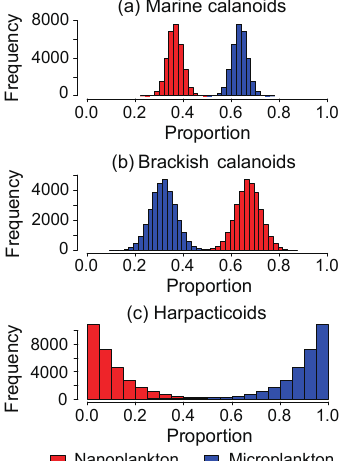
Figure 6. Comparison of the dietary compositions of major cope- pod groups: (a) Marine calanoids, including Acartia hudson- ica , Acartia omorii , Bestiolina coreana , Calanus sinicus , Clau- socalanus furcatus , Centropages abdominalis , Centropages dor- sispinatus , Paracalanus aculeatus , Paraeuchaeta plana , Labido- cera rotunda , Labidocera euchaeta , Tortanus dextrilobatus , and Tortanus forcipatus ; (b) brackish calanoids, including Acartia ohtsukai , Acartia erythraea , Eurytemora Pacifica , Paracalanus parvus , Pseudodiaptomus koreanus , Pseudodiaptomus marinus , and Sinocalanus tenellus ; and (c)